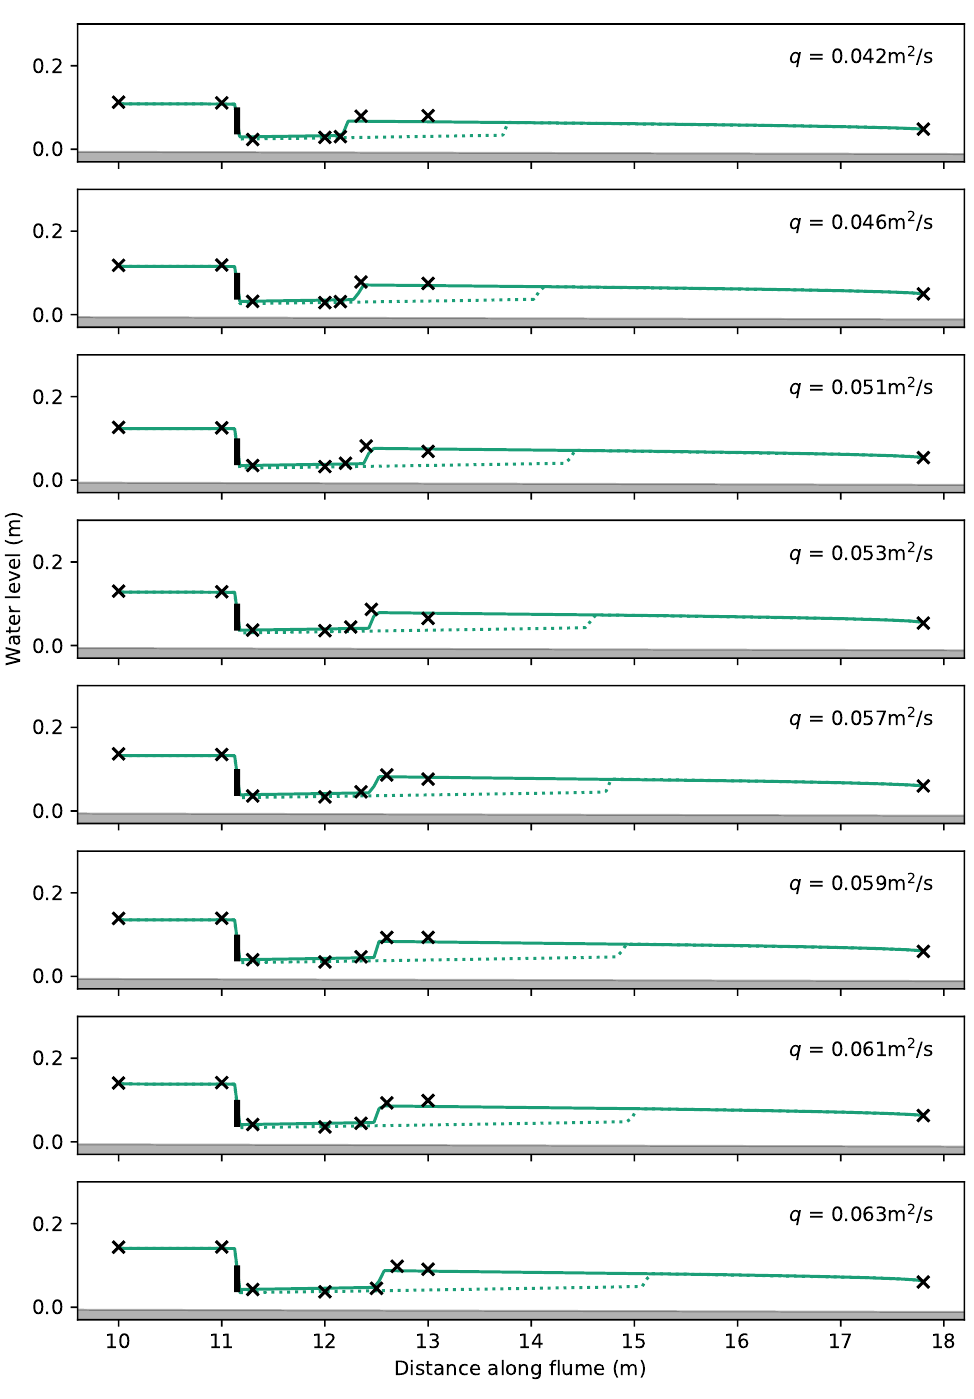
Figure A4. Results for configuration